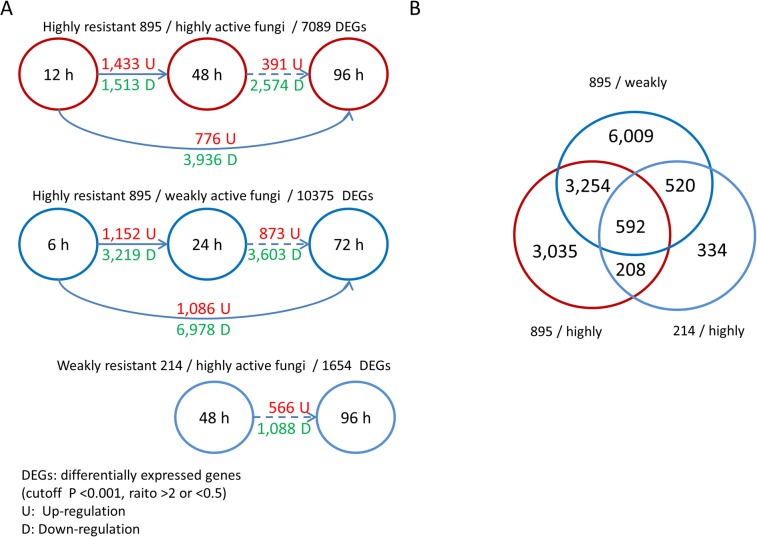
More poplar genes were up-regulated in the highly resistant 895/highly active fungus group at the early stage.(A) The differentially expressed poplar genes between different time points in three groups. (B) The overlapping DEGs among the three groups.